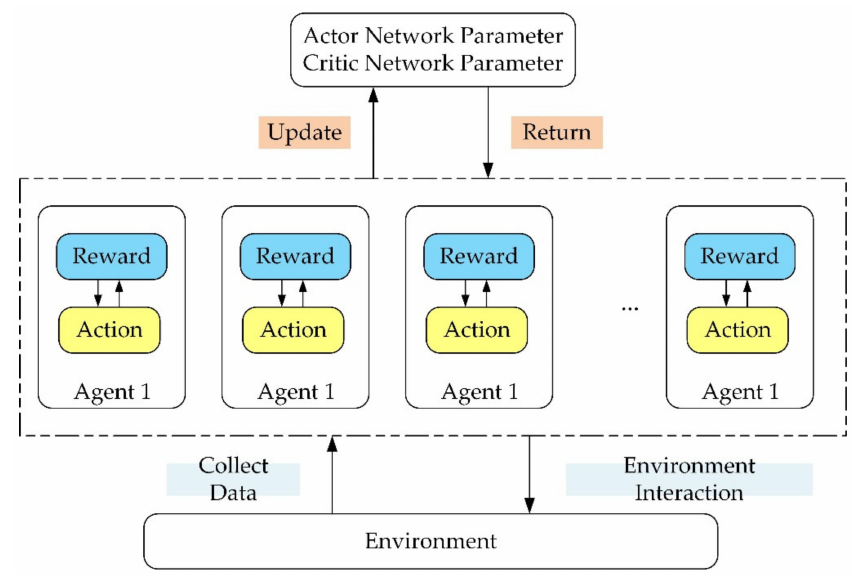
Figure 7. Training